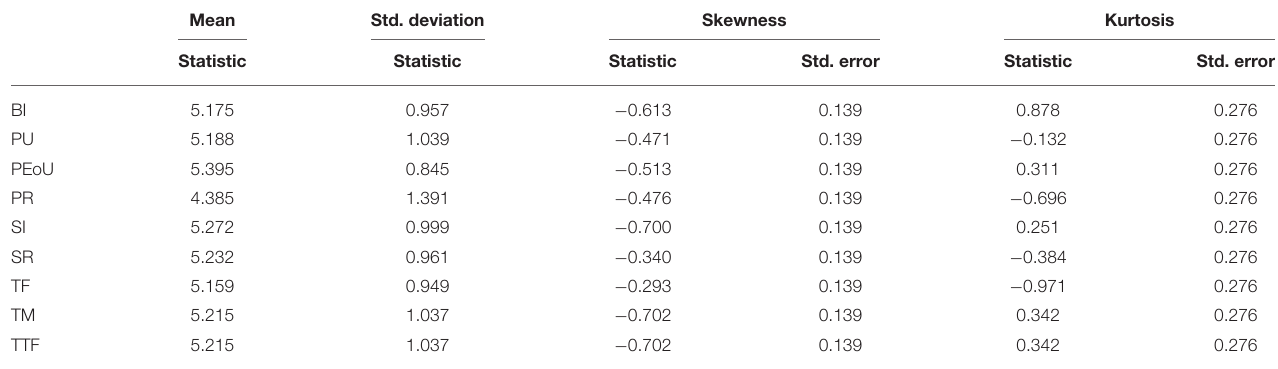
TABLE 4 | Descriptive statistics: mean, standard deviations (S.D.) skewness, and kurtosis.